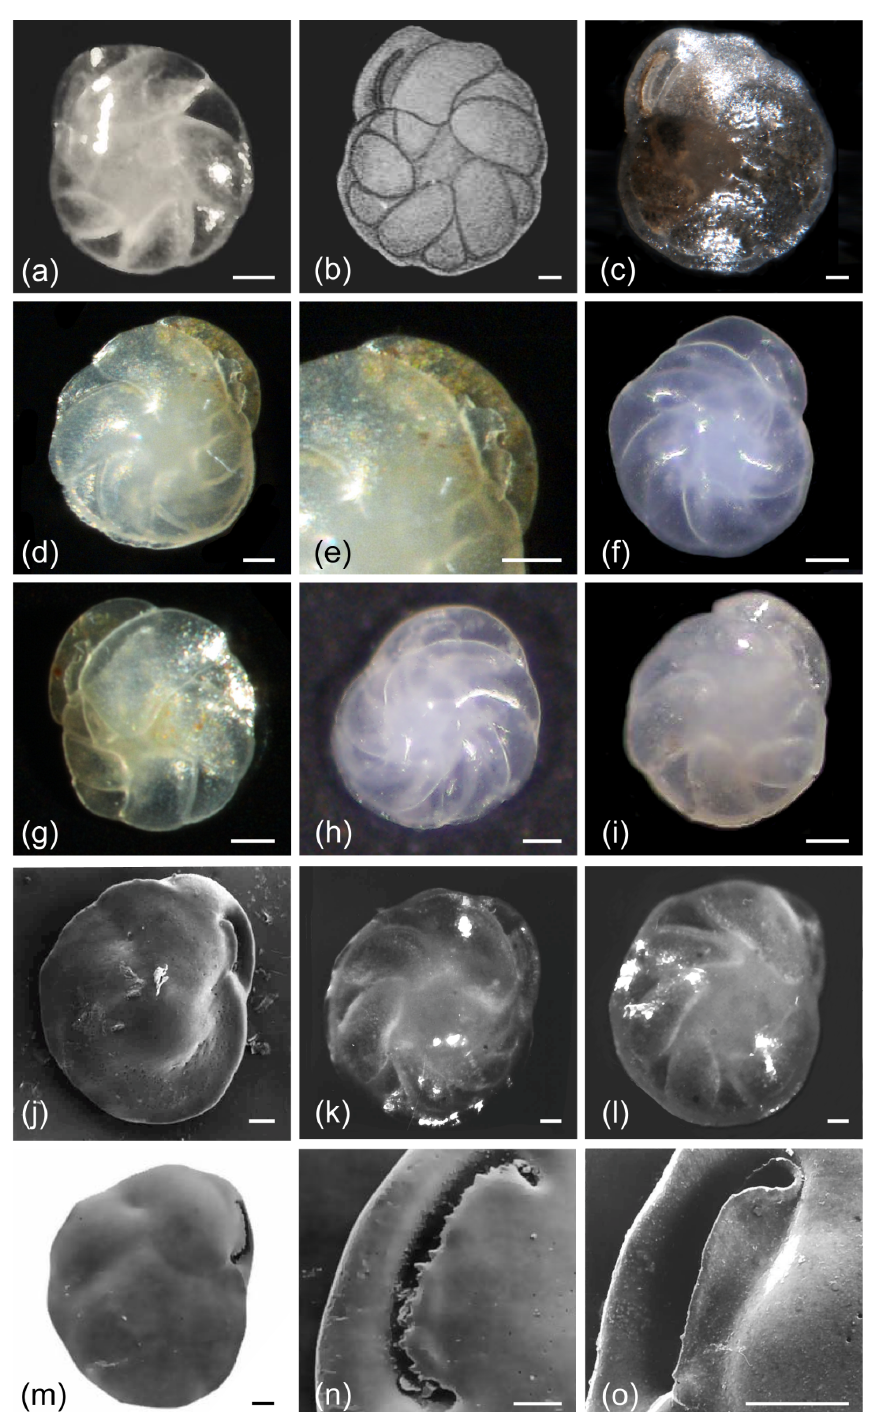
Figure 2. Cassidulina neoteretis (a, d–j, o) and Cassidulina teretis (b–c, k–n) . (a) Holotype image of C. neoteretis . (b) Original holotype illustration of C. teretis and (c) its re-image. (d–i) Light microscope images of C. neoteretis ; the slightly carinate lip of the species is evident in (d )– (e) and (g) , despite the flap of the aperture being slightly broken in both specimens. (k–l) Light microscope images of C. teretis . (j, m) SEM micrographs of C. neoteretis (j) and C. teretis (m) . (n–o) Comparison between the apertural lips of (n) C. teretis vs. (o) C. neoteretis in SEM. All scale bars denote 50µm, aside from (n) – (o) where they denote 25µm. See Supplement Table S1 for sample details. (a, j–o) Reproduced from Seidenkrantz (1995) with the permission of the Journal of Micropalaeontology . (b) Reproduced with the permission of the Cushman Foundation for Foraminiferal Research. (c) Re-image from the Paleobiology Collections of the Smithsonian National Museum of Natural History (https://collections.nmnh.si.edu/search/paleo/, last access: 19 October 2020), made available under